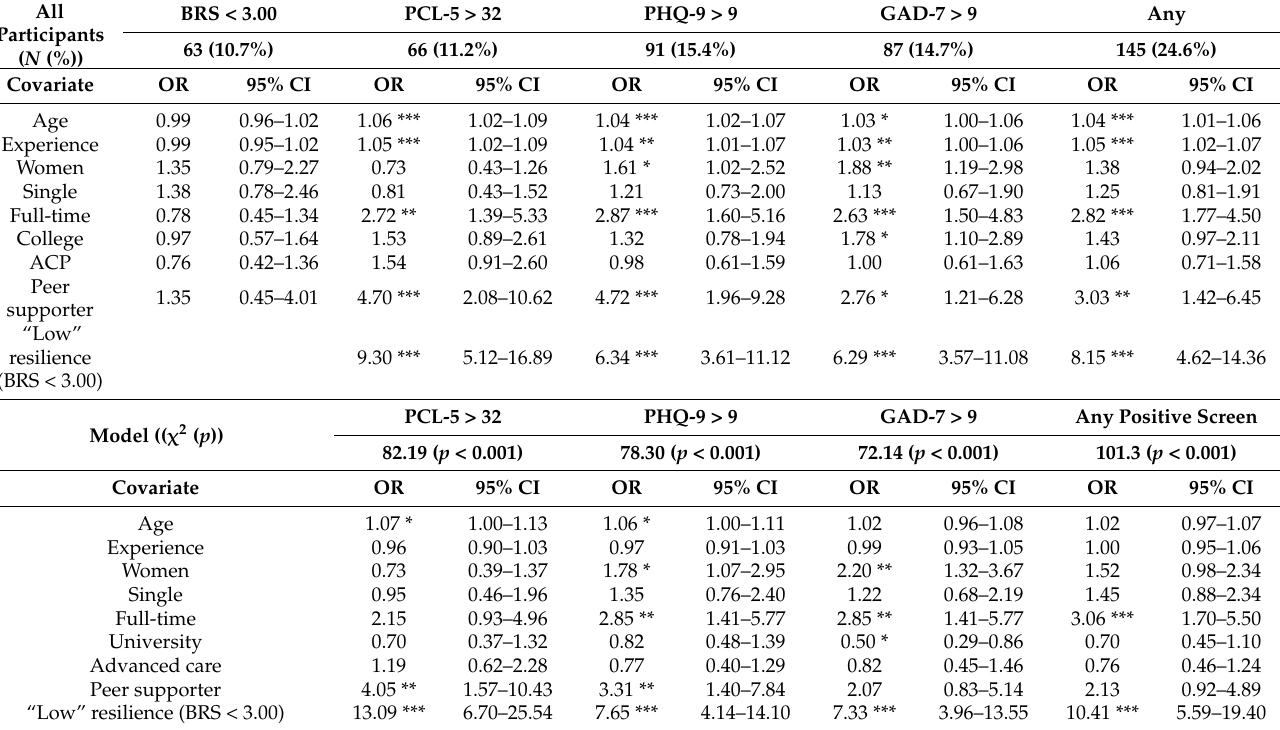
Table 2. Positive mental disorder screens stratified by demographics and resilience in